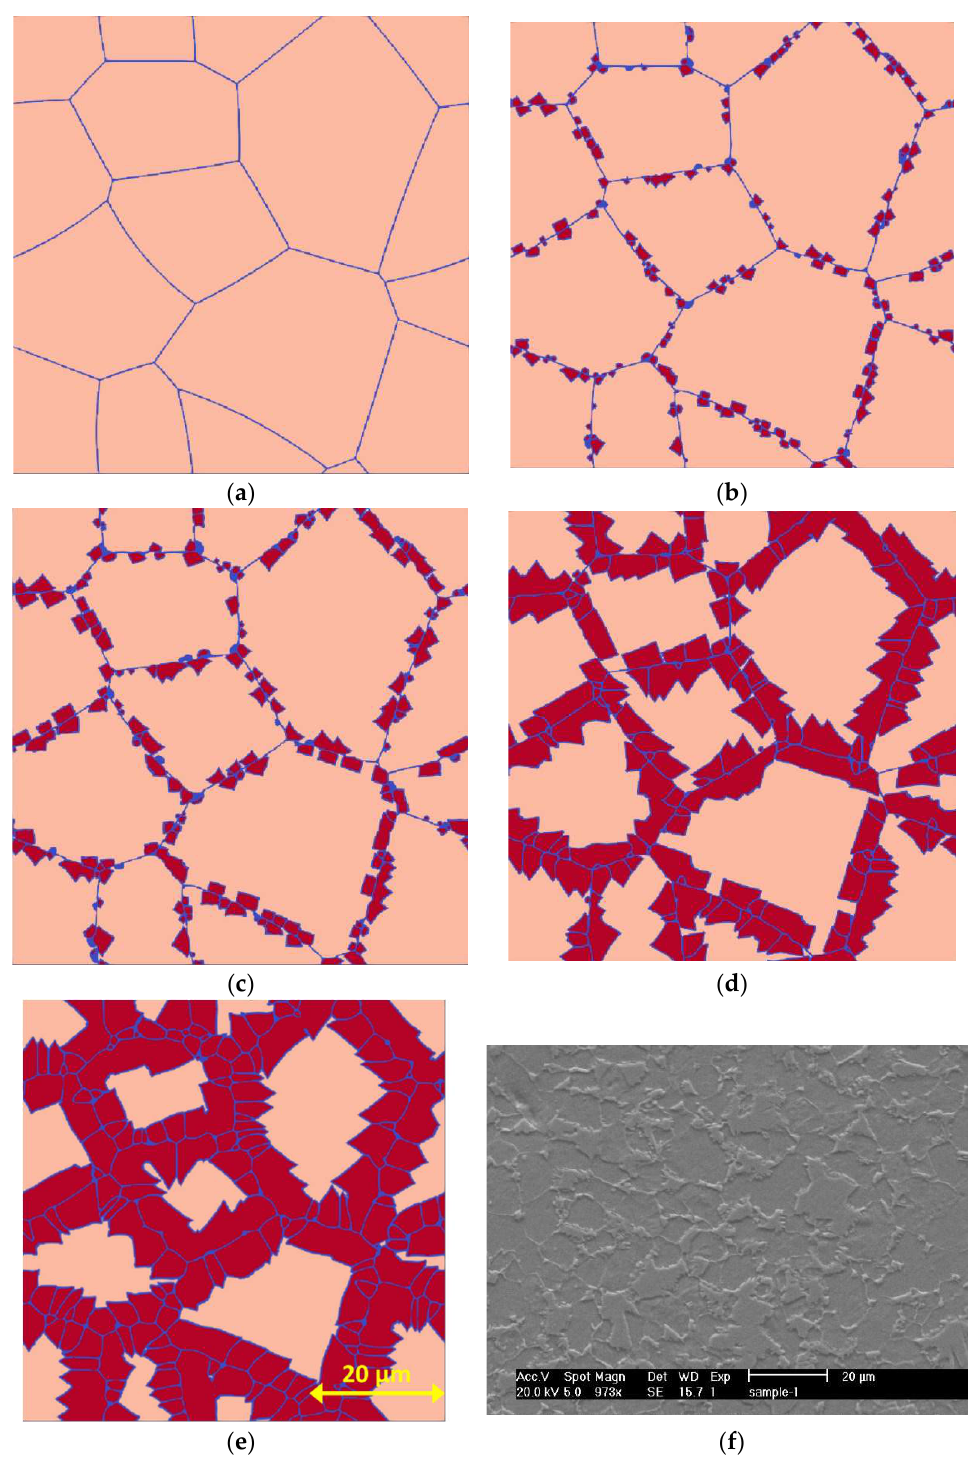
Figure 3. Progression of the results of the PF simulation: ( a ) initial state, ( b ) 15 s, ( c ) 1 min, ( d ) 10 min, and ( e ) after quenching; and ( f ) SEM image of a sample undergoing the same heat treatment.